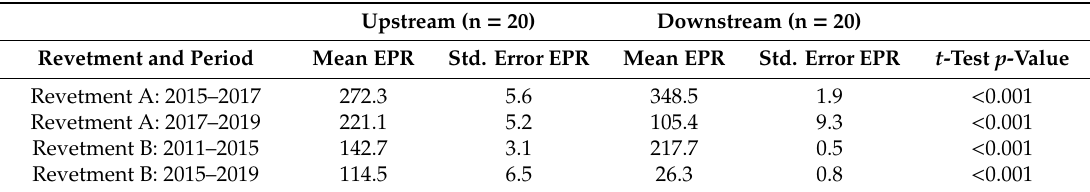
Table 10. End Point Rate (EPR, m / y) di ff erence of means by upstream / downstream position and period.